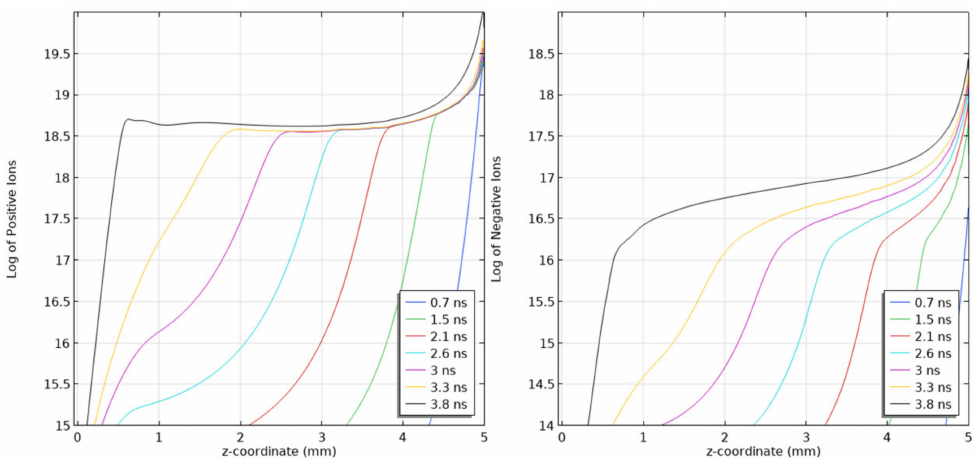
Figure 13. Line diagrams along the symmetry axis of the log of the Positive Ion Density profile ( left ) and the Negative Ion Density profile ( right ) for a streamer propagating in a 5 mm air gap at a pressure of 10 kPa. Applied voltage of 5 kV. Scaling parameter for density profiles: 20 on logarithmic plot represents a density value of 10 20 m − 3 .